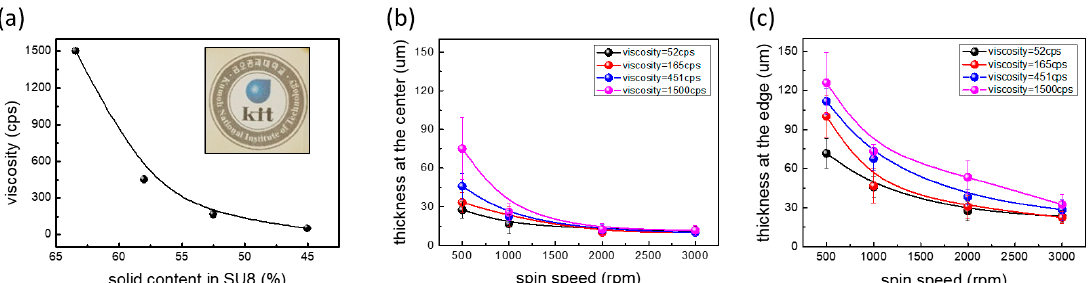
Figure 2. ( a ) Viscosity of the SU8 prepolymer solution as a function of the solid content and ( b , c ) electrode thickness at the ( b ) center and ( c ) edge as a function of the spin-coating speed for different prepolymer solution viscosities. The inset in (a) is a photograph of a SU8-embedded silver-nanowire-embedded electrode.